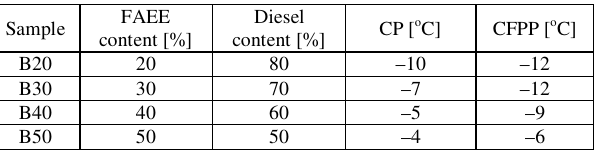
Table 2. Low temperature properties of the fuel with various FAEE content